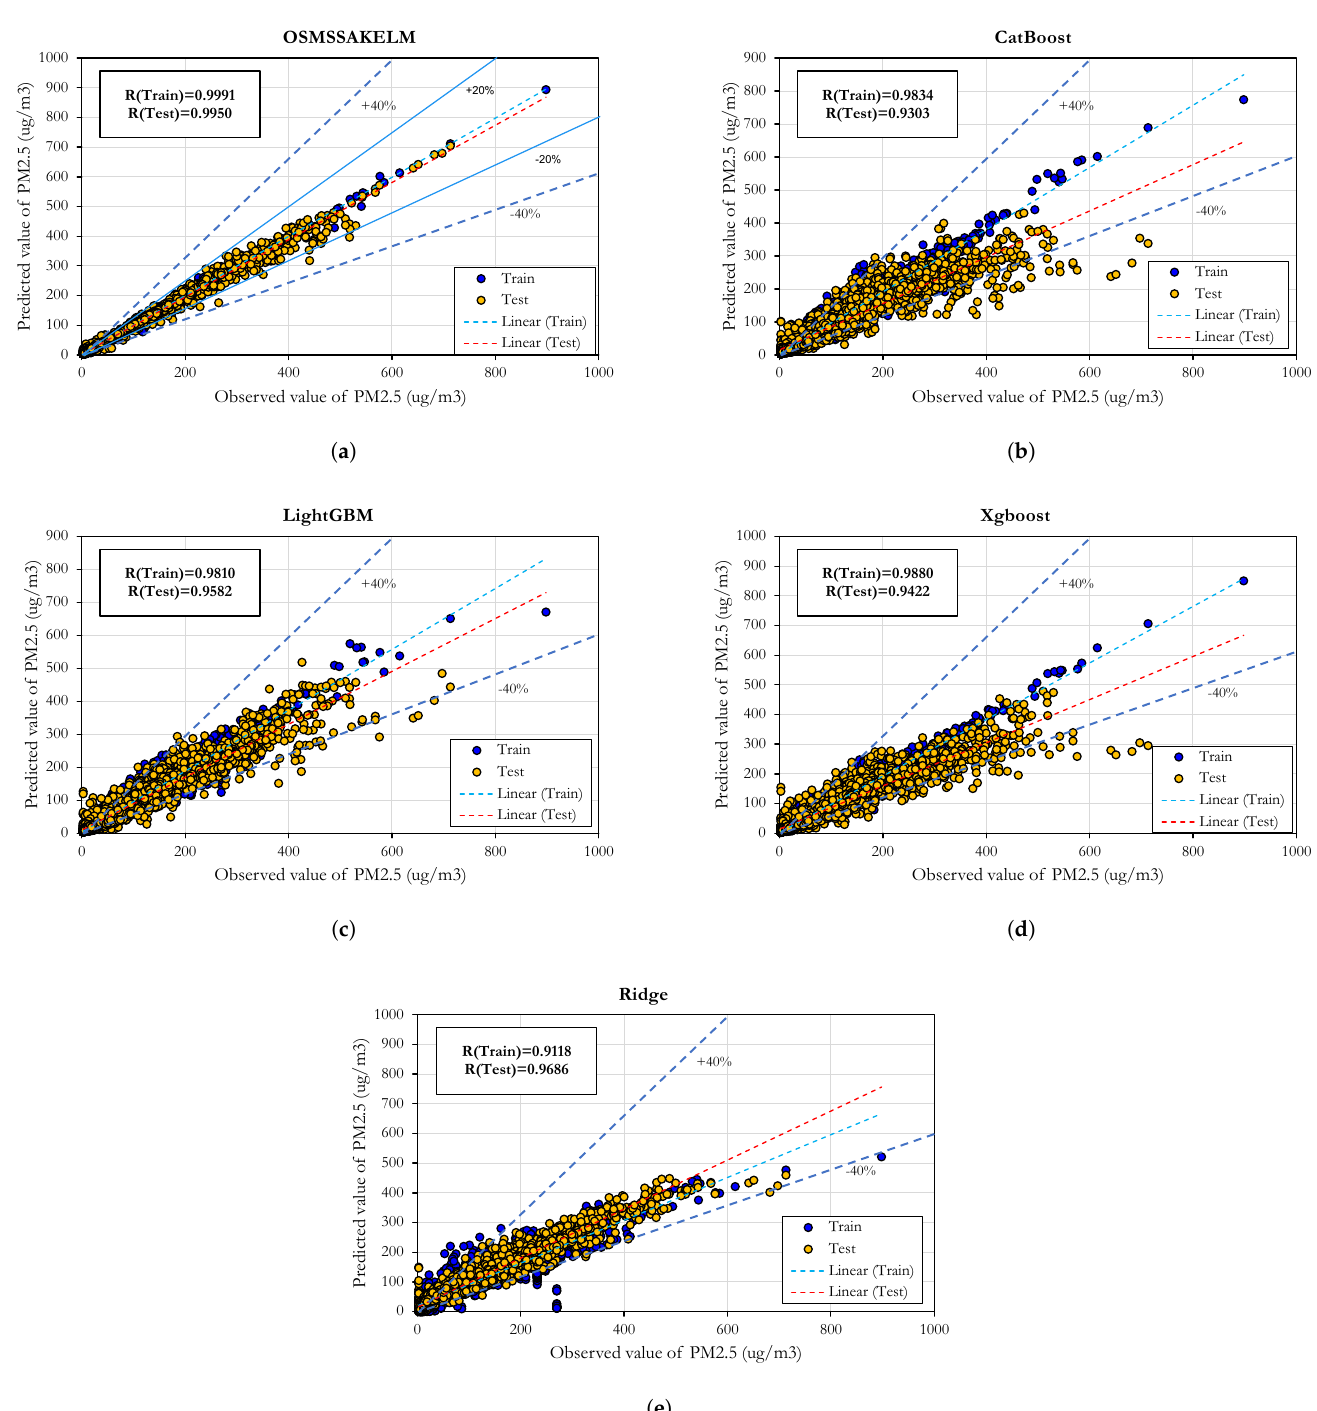
Figure 19. Scatter plots of different ML models. Figures 20 and 21 compare the proposed model for the training and testing phases based on the RMSE, MdAE, KGE, and R metrics versus the other studied models. In both the testing and training stages, these plots demonstrate that the WD-OSMSSAKELM model delivered high efficiency, accuracy, and practicality. They visually confirm that the error range was minimum and optimal, and the volatility was low, with better error results, which provide a powerful prediction